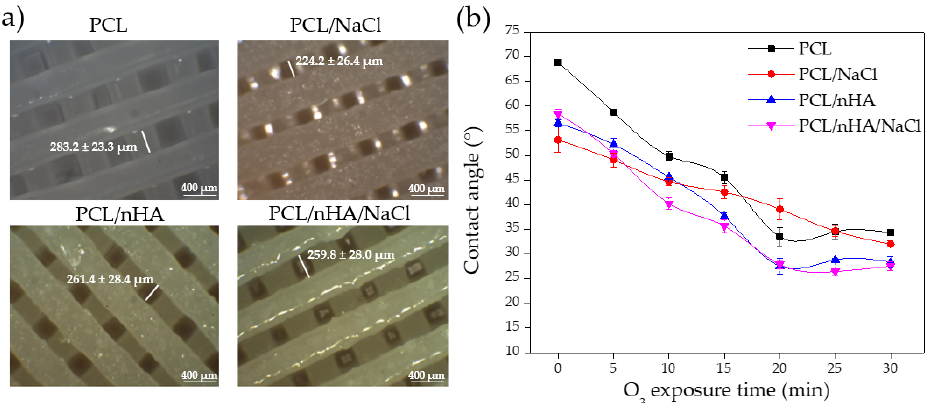
Figure 6. ( a ) Internal microchannel, and ( b ) graph of contact angle vs. O 3 exposure time of the different